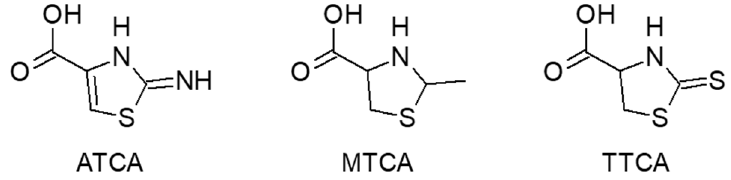
Figure 14. Chemical structures of 2-aminothiazoline-4-carboxylic acid (ATCA), 2-methylthiazolidine-4-carboxylic acid (MTCA), and 2-thiothiazolidine-4-carboxylic acid (TTCA). Although LLE o ff ered good accuracy and sensitivity with an LOD of 0.43 ng / mL, derivatization of interference compounds (secondary amino acids) was required to remove interference peaks [72]. It was applied to human blood and revealed that ATCA concentrations in blood from a cyanide-poisoned person were approximately four-fold higher than those from non-poisoned